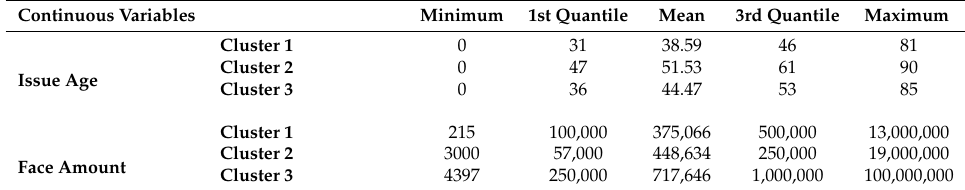
Table A3. Data summary for numerical variables within the 3 optimal